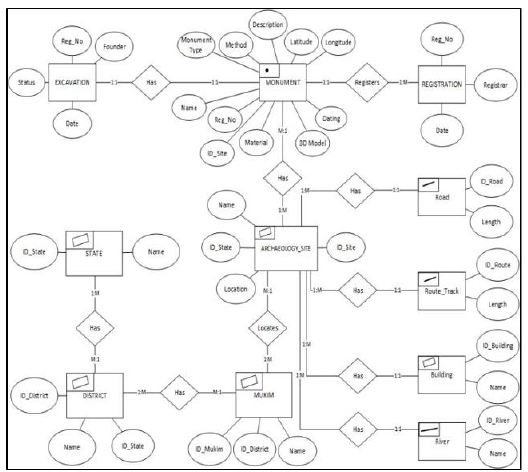
Figure 7: Entity Related Diagram